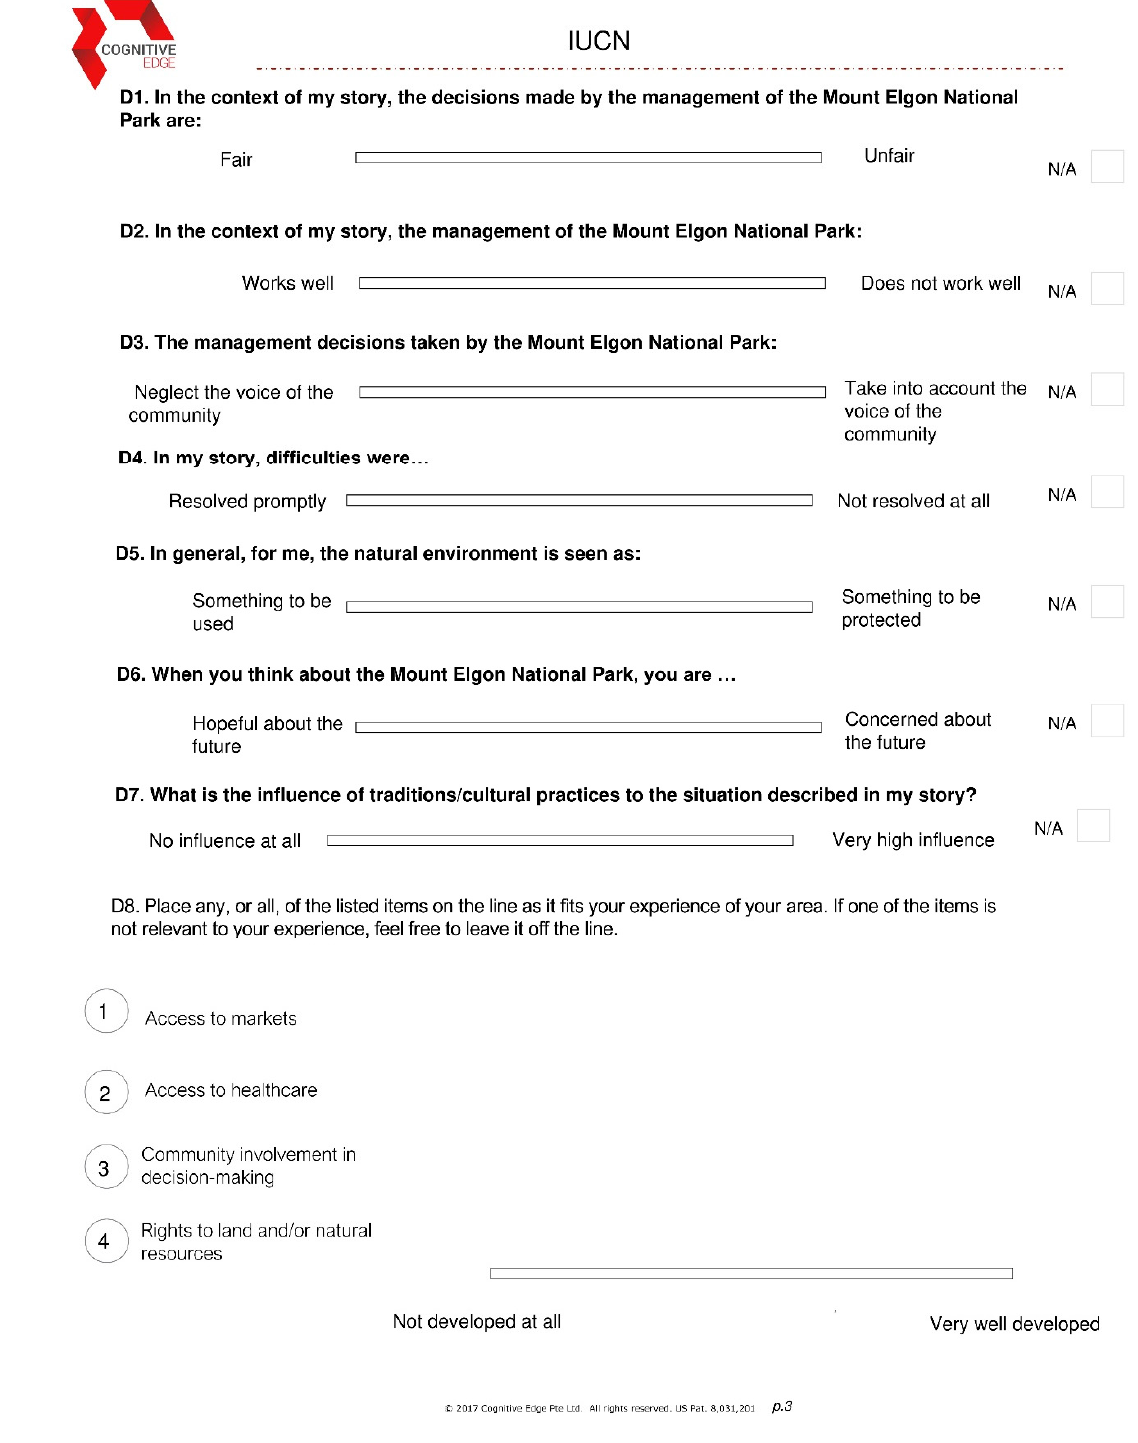
Figure A3. Details about Story Diads Picture A3: Details about Story Diads Section